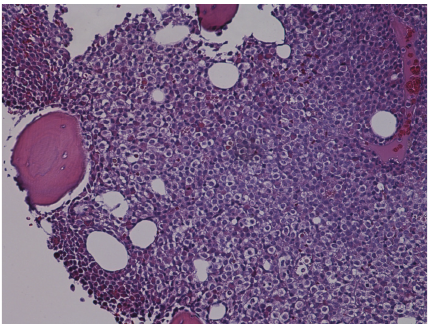
Figure 1: The patient’s bone marrow biopsy revealed hypercellular bone marrow.